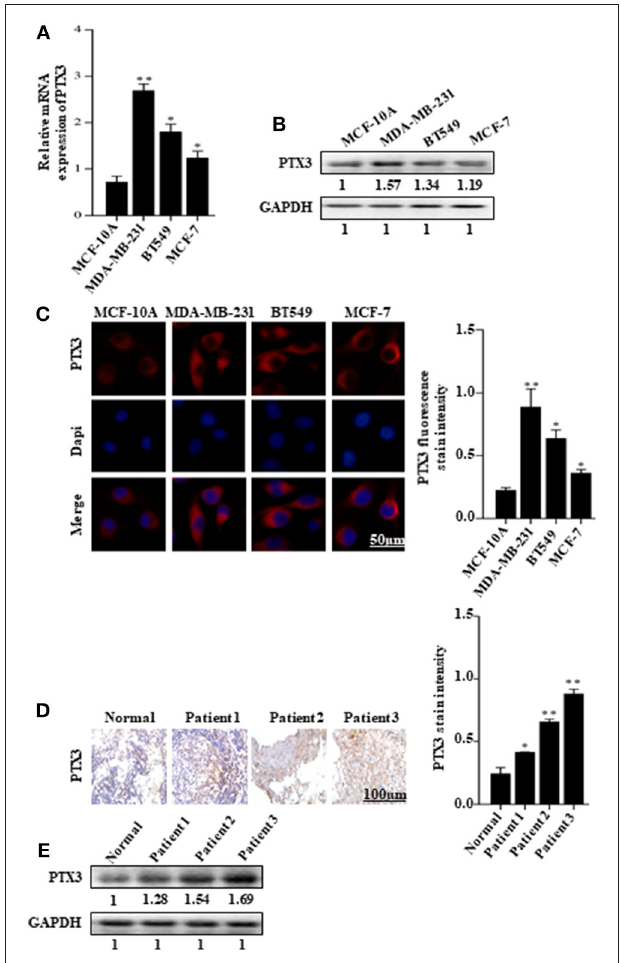
FIGURE 1 | PTX3 expression in breast cancer cells and tissues. (A) Assessment of PTX3 gene expression relative to GAPDH in MCF-10A, MDA-MB-231, BT549, and MCF-7 cells by qPCR. (B) PTX3 protein expression in MCF-10A, MDA-MB-231, BT549, and MCF-7 cells. Total protein from cell lysates was subjected to 12% SDS-PAGE and analyzed by western blotting with antibodies against PTX3. GAPDH was used as loading control. (C) Representative micrographs of PTX3 expression in MCF-10A, MDA-MB-231, BT549, and MCF-7 cells. The cells were stained with anti-PTX3 antibodies (red) and DAPI (blue) and observed under a fluorescence microscope (bar = 50 µ m; magnification, 400x). (D) PTX3 expression in human breast cancer tissues (patient 1, first-grade tumor, molecular subtype HER2; patient 2, second-grade tumor, molecular subtype BLBC; and patient 3, third-grade tumor, molecular subtype BLBC) examined by immunohistochemical staining. (Scale bars = 100 µ m; magnification, 200x). (E) PTX3 expression in human breast cancer tissues and normal breast tissue. Tissues were homogenized and equal amount of proteins were subjected to SDS-PAGE and analyzed by western blotting with antibodies against PTX3. GAPDH was used as an internal control. The data are reported as mean ± SEM of three independent experiments. *Indicates statistical significance, P < 0.05; ** P <